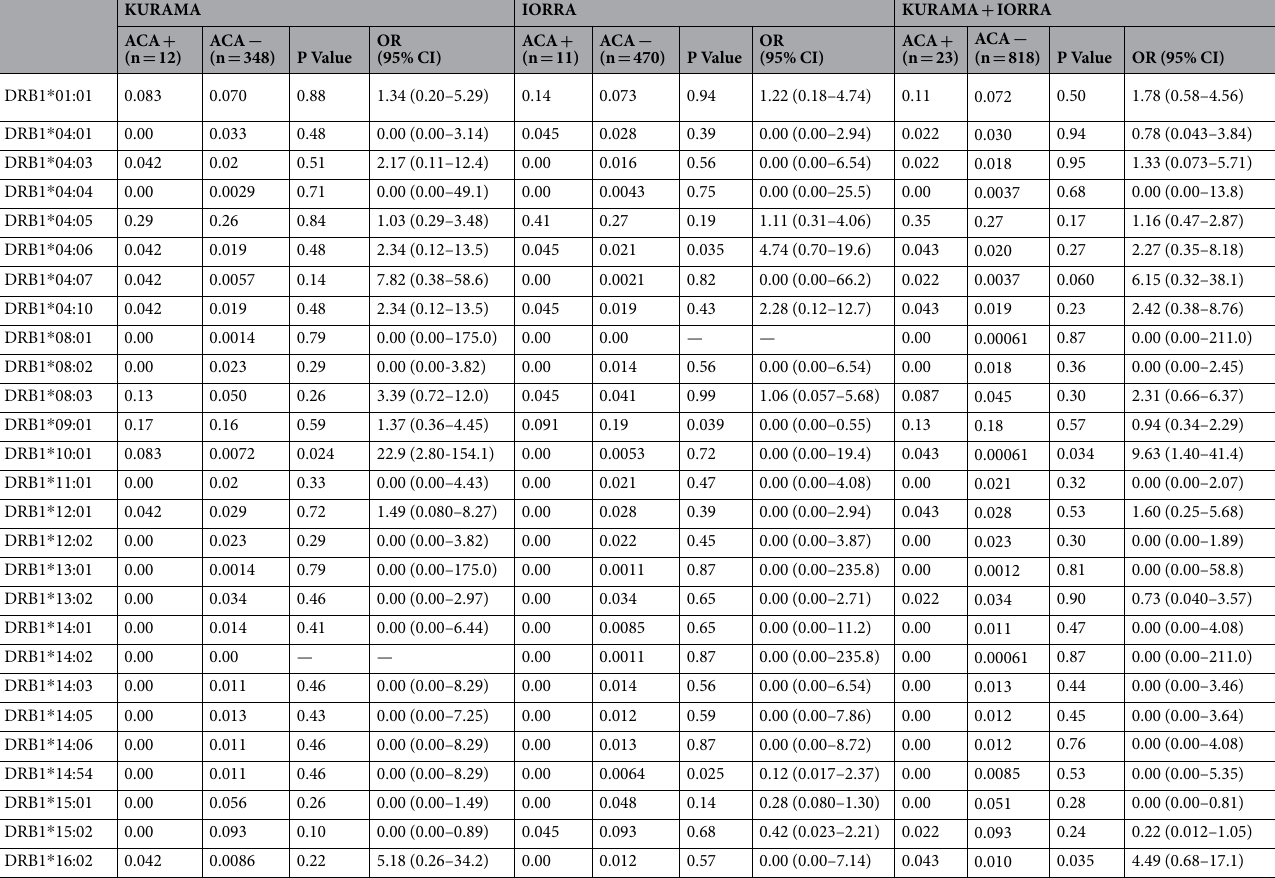
Table 5. Association of HLA-DRB1 alleles with ACA-positivity. KURAMA, Kyoto University Rheumatoid Arthritis Management Alliance; IORRA, Institute of Rheumatology, Rheumatoid arthritis; ACA, anti- centromere antibody; OR, odds ratio; 95% CI, 95% confidence